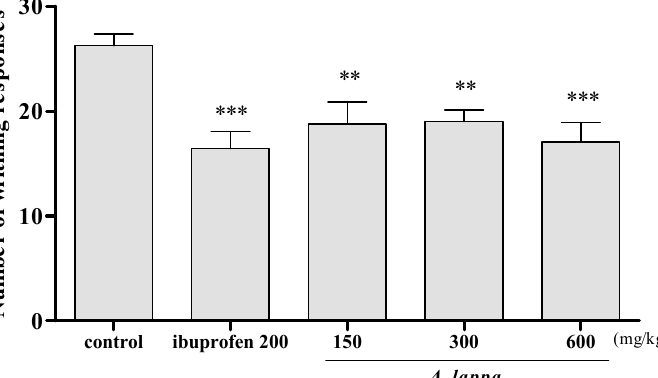
Figure 5. The acetic acid induced writhing responses in ICR mice. Mice were orally administered with ibuprofen and A. lappa and intra-peritoneally injected with 0.7% acetic acid. Each group had 7–8 mice; ** p < 0.05 vs. control, *** p < 0.001 vs. control.